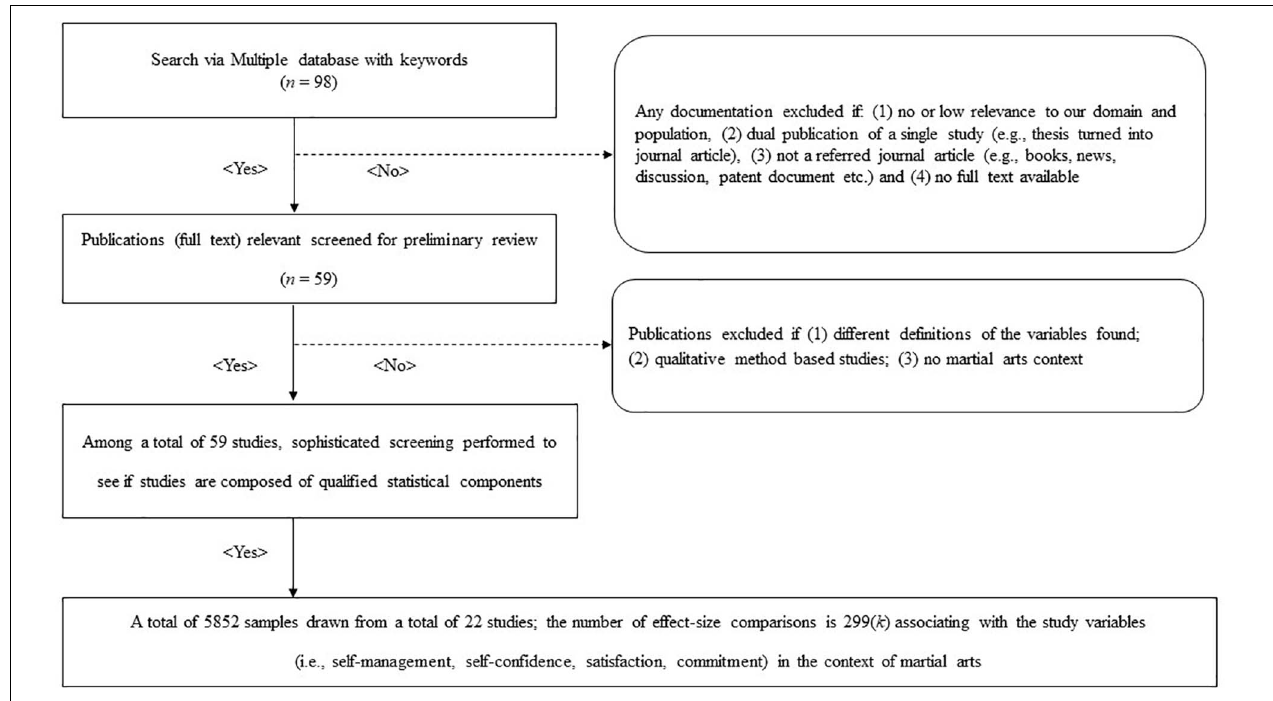
FIGURE 1 | Flowchart of the study selection process.